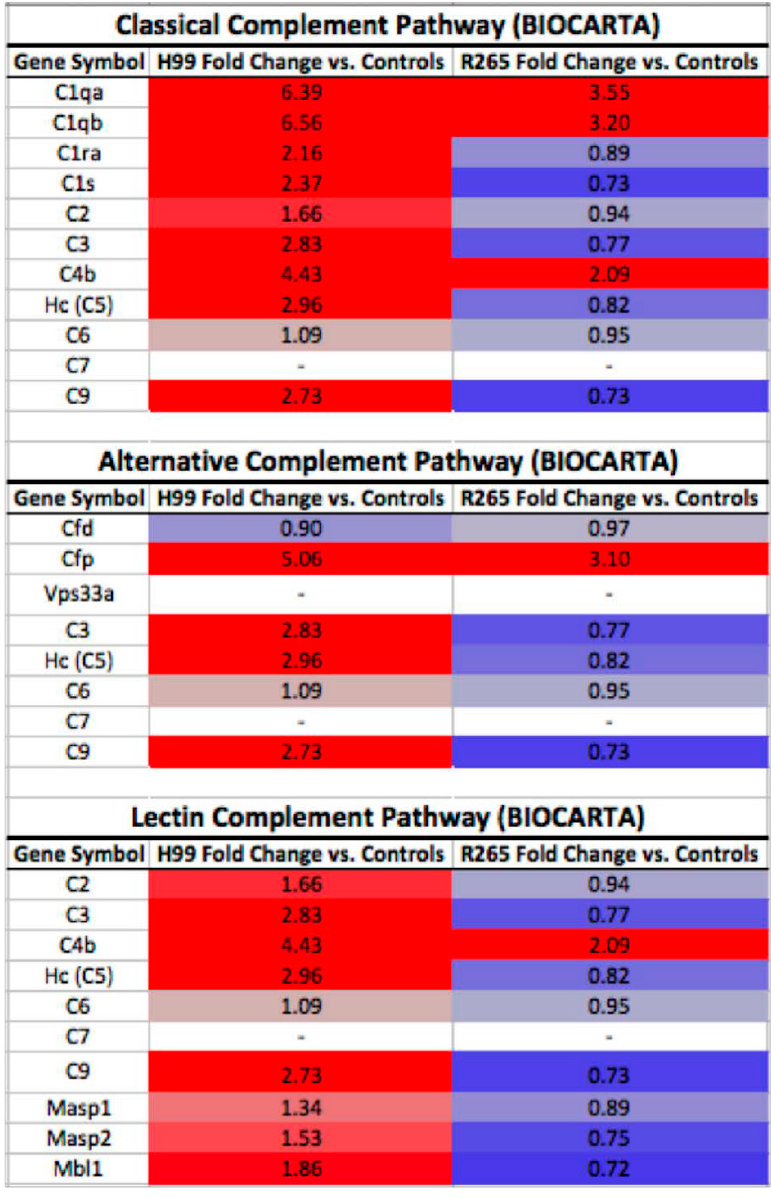
Figure 4. Alteration in expression of genes involved in the classical, alternative, and lectin com- plement activation pathways. Relative fold change for each gene due to infection with C. gattii R265 and C. neoformans H99 in comparison to healthy control mice. Genes listed are from BIOCARTA- defined pathways, with solid red representing 2-fold up-regulation and solid blue representing 2-fold down-regulation. Genes with no fold change listed did not have probes on the microarray